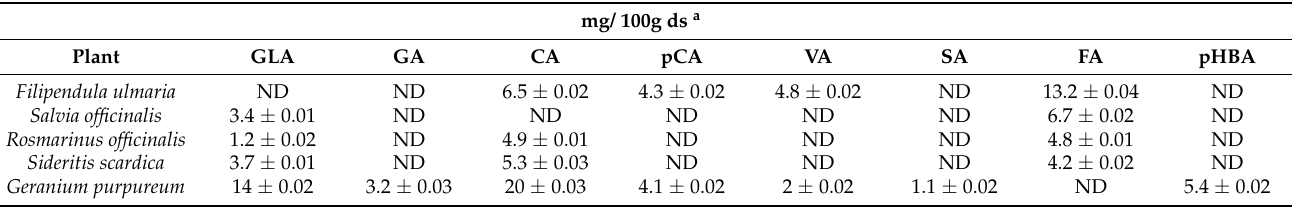
Table 2. Phenolic acid concentrations of plant extracts studied.